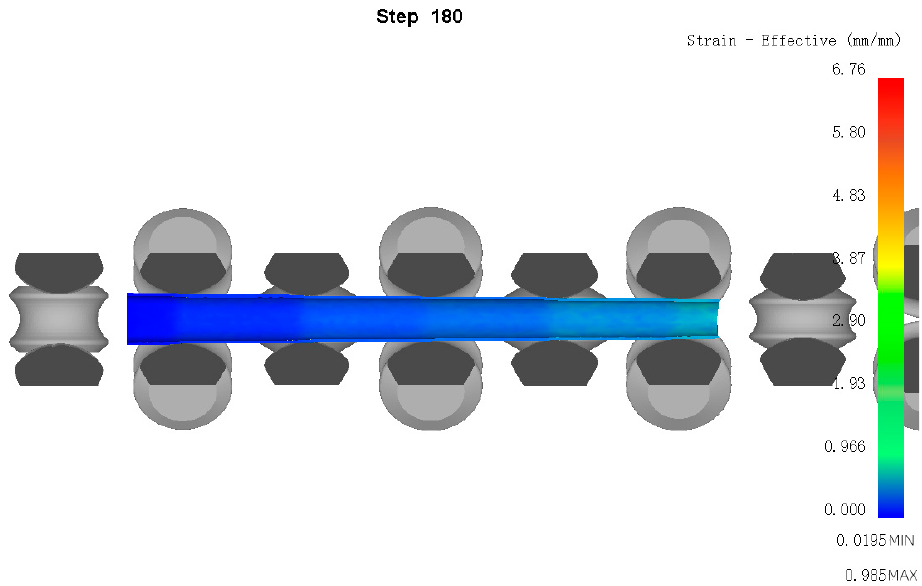
Figure 7. Equivalent strain distribution of the finite element model (step 180).